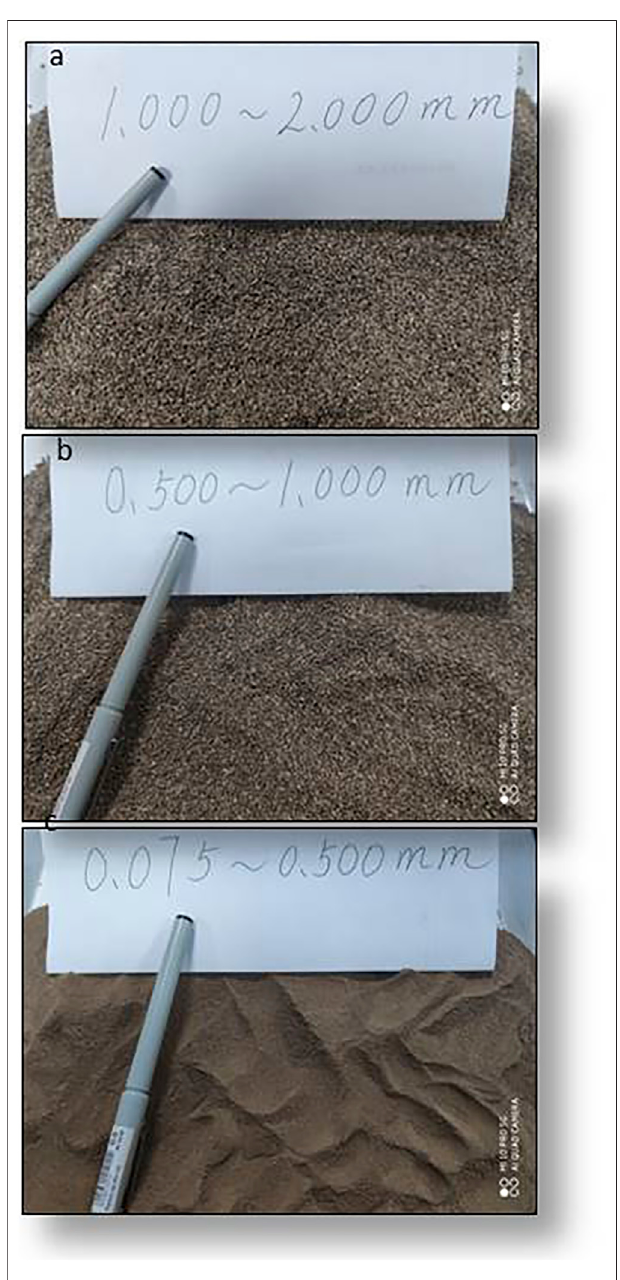
FIGURE 4 | Screening results of particles with three sizes. (A) Angular gravel with a diameter of 1.000 – 2.000 mm. (B) Coarse sand with a diameter of 0.500 – 1.000 mm. (C) Sand loess with a diameter of 0.075 – 0.500